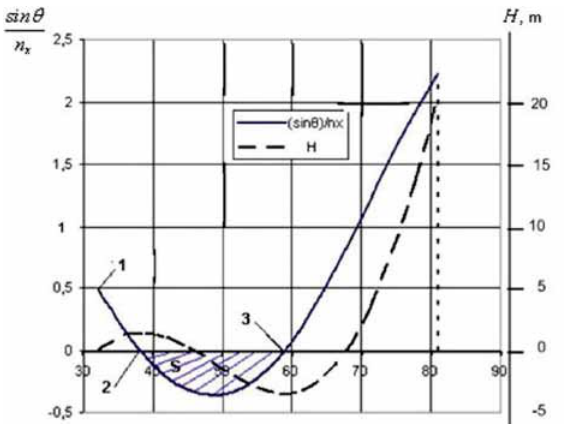
Fig. 6. Dependence of derivative dH/dH e on value Н е for various angles of the installation of a launcher under the condition that V = 95 km/h, P = 350 N